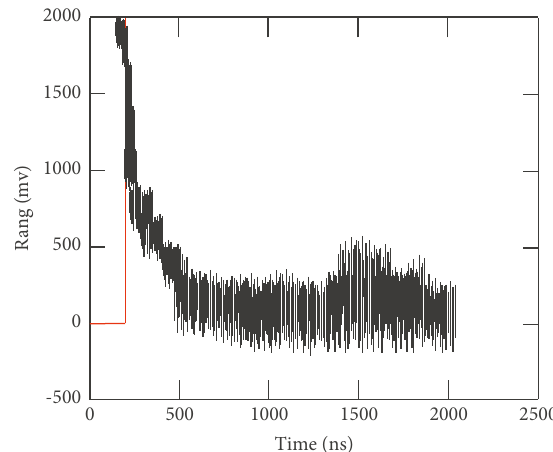
Figure 1: Simulation of a single nuclear signal.